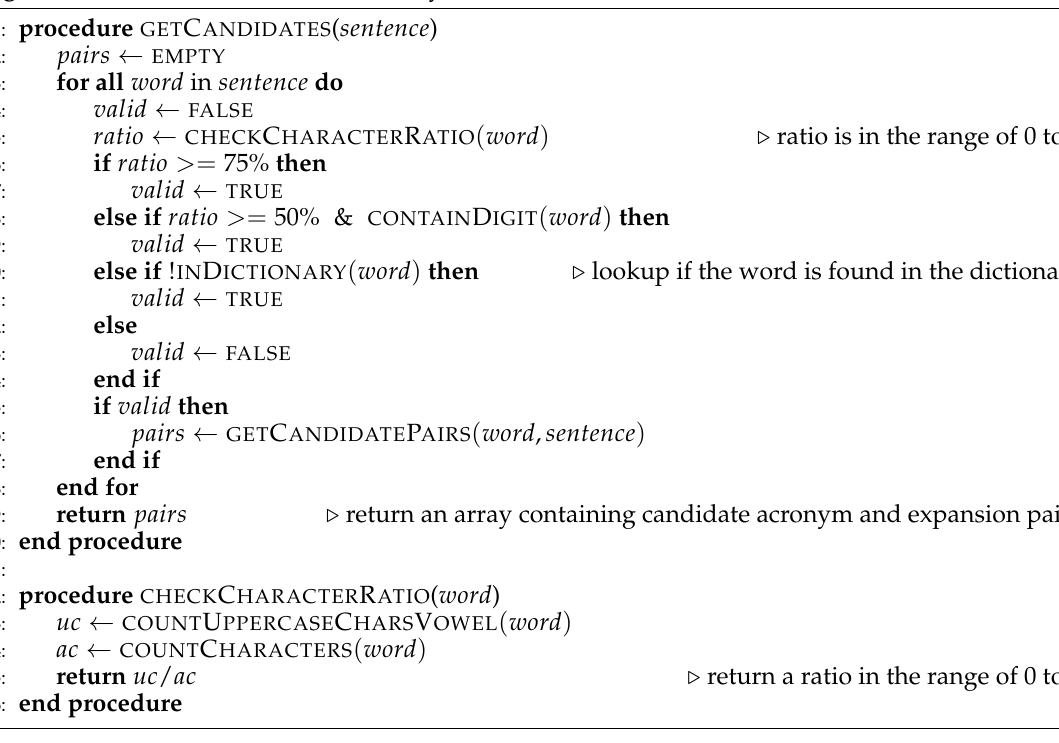
Algorithm 1 Generate candidate of acronyms.